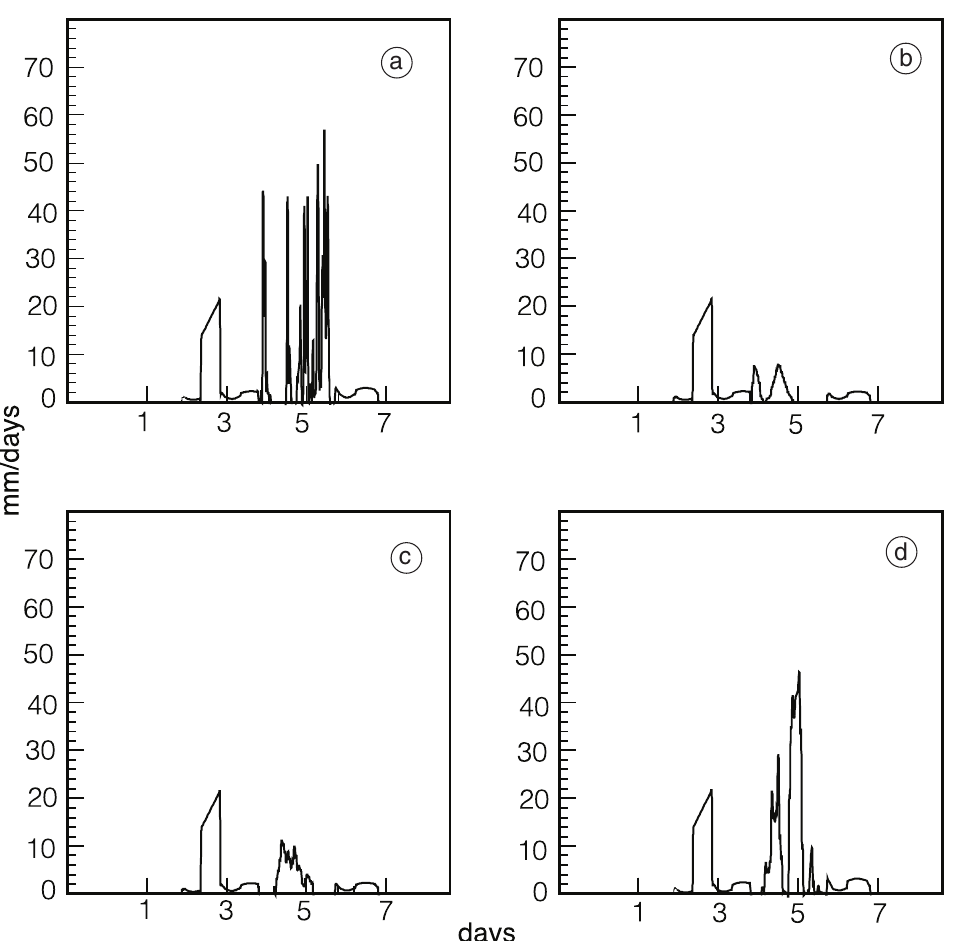
Fig. 7a-d. The run-off in mm/days from 1 to 7 May 1998, obtained when BATS is coupled to: a) the observations (OBS); b) the rainfall produced by the model simulation performed using one domain only at 27 km; c) the rainfall produced by the model simulation performed using 2 domains with the highest resolution being 9 km; d) the rainfall produced by the model simulation performed using three domains with the highest resolution being 3 km.